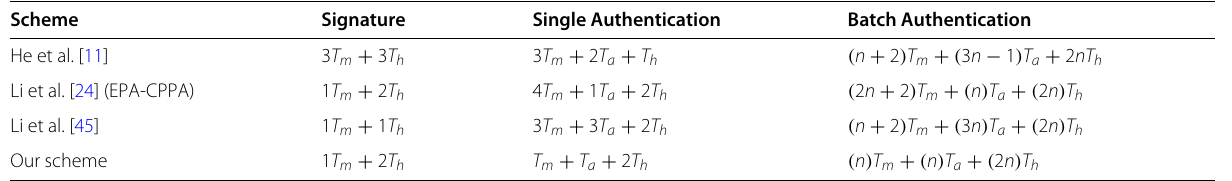
Table 3 Comparisons of computational overhead